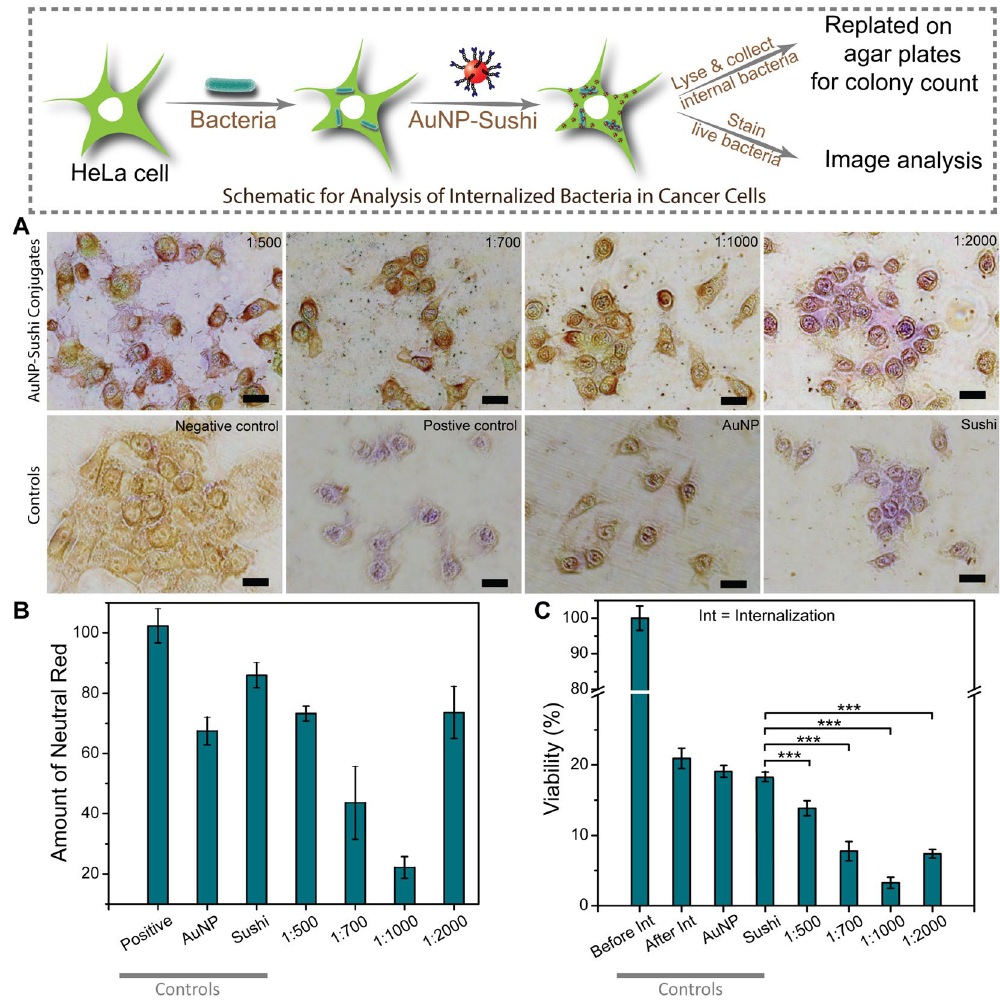
Figure 4. HeLa cell infection assays with S. typhi internalization. ( A ) Optical microscopy images: Load- dependent NP-sushi conjugate activity confirming maximum antibiotic effect at 1:1000 ratio. The total peptide concentration was fixed at 4 µ M in all the cases. Purple color indicates live bacteria at the time of neutral red dye incubation. Negative control: HeLa cells alone, Positive control: HeLa cells with only S. typhi , AuNP: HeLa cells with only AuNPs, Sushi: HeLa cells with only sushi peptide. Scale bar: 20 μ m. ( B ) Quantification of neutral red using ImageJ software, ( C ) Percent viability by colony count of S. typhi bacteria internalised in HeLa cells after antibacterial treatment with free and conjugated sushi